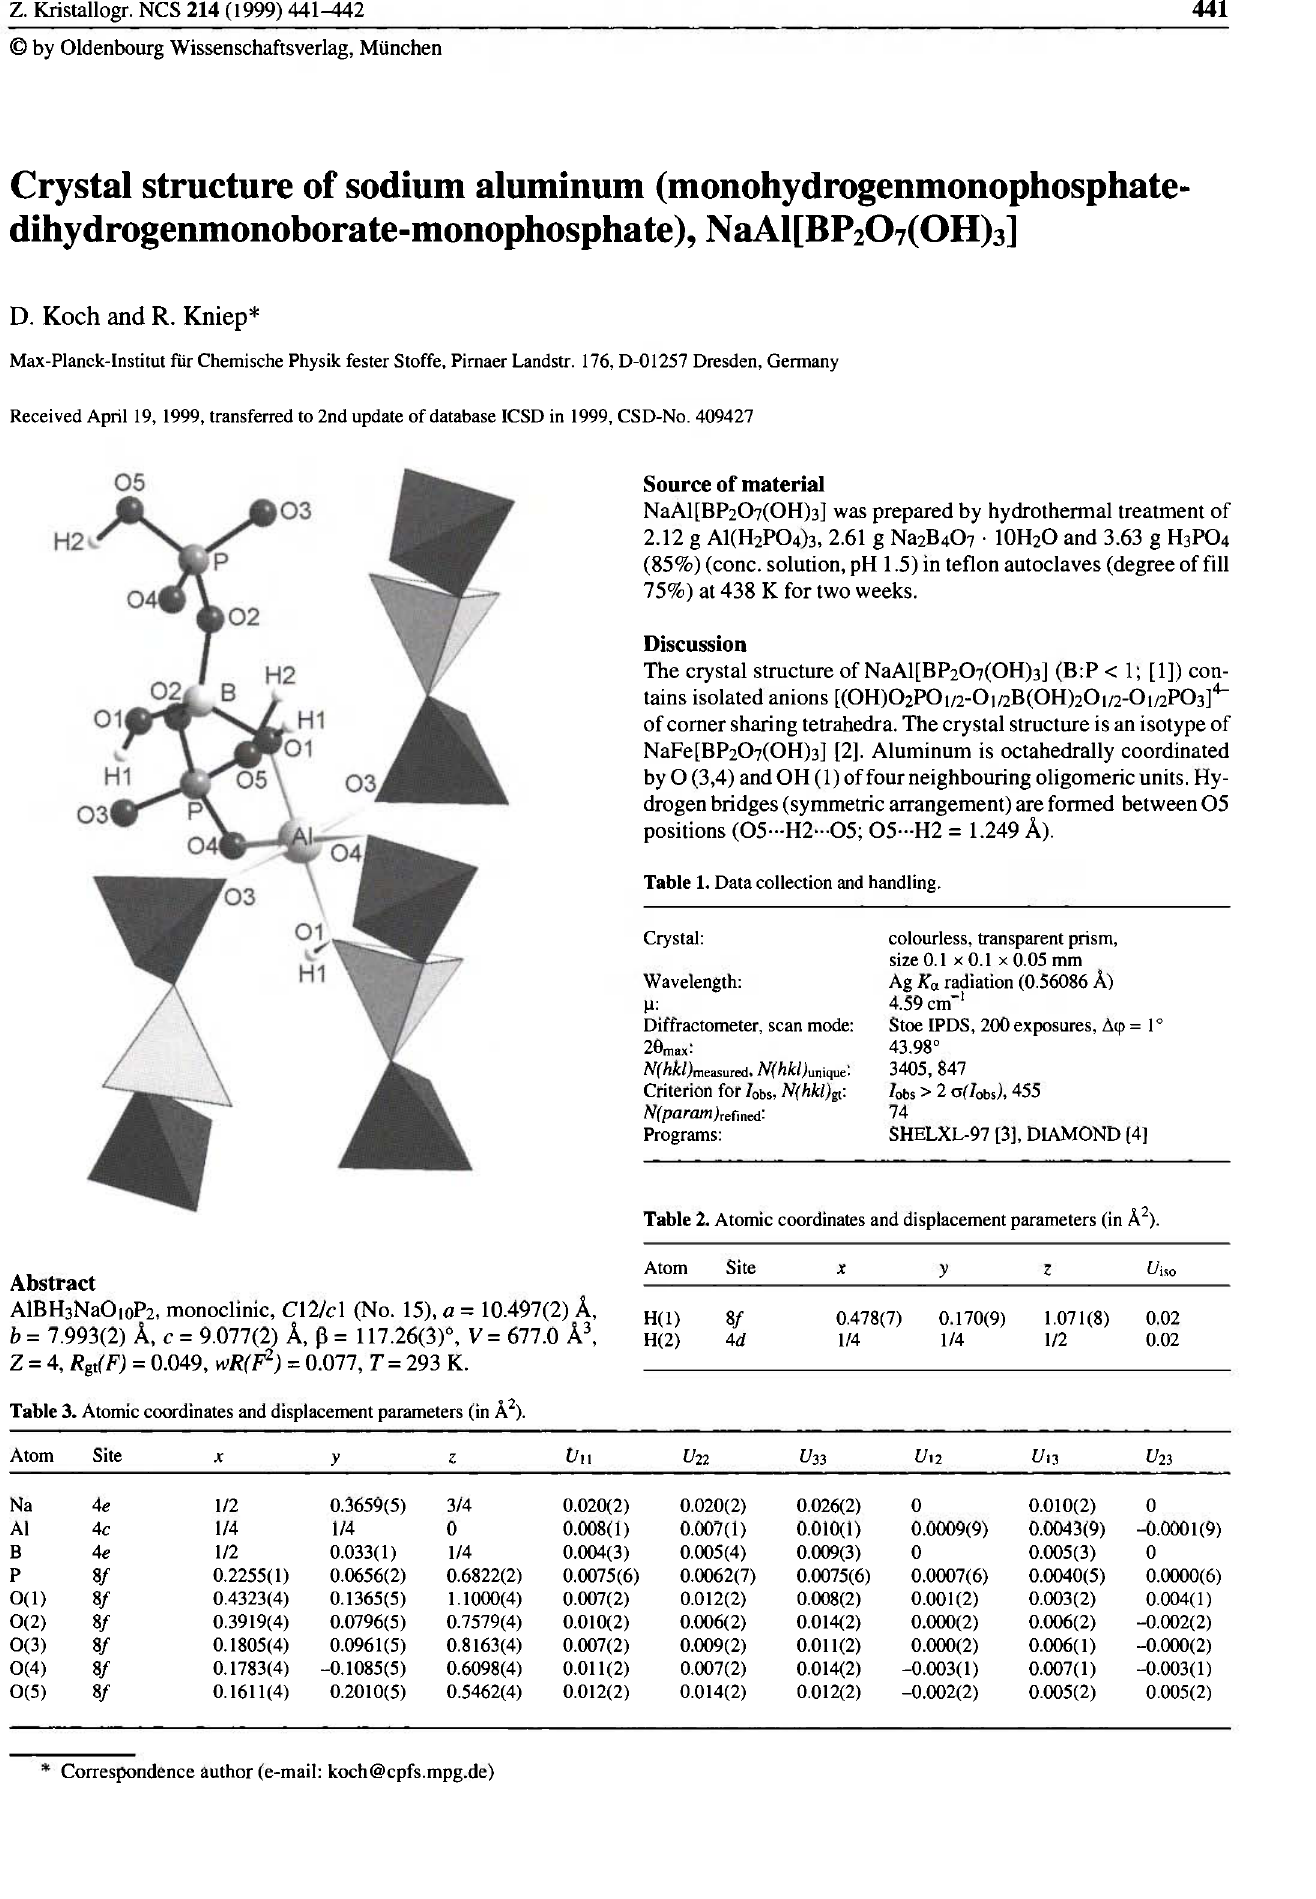
Table 3. Atomic coordinates and displacement parameters (in Ä 2